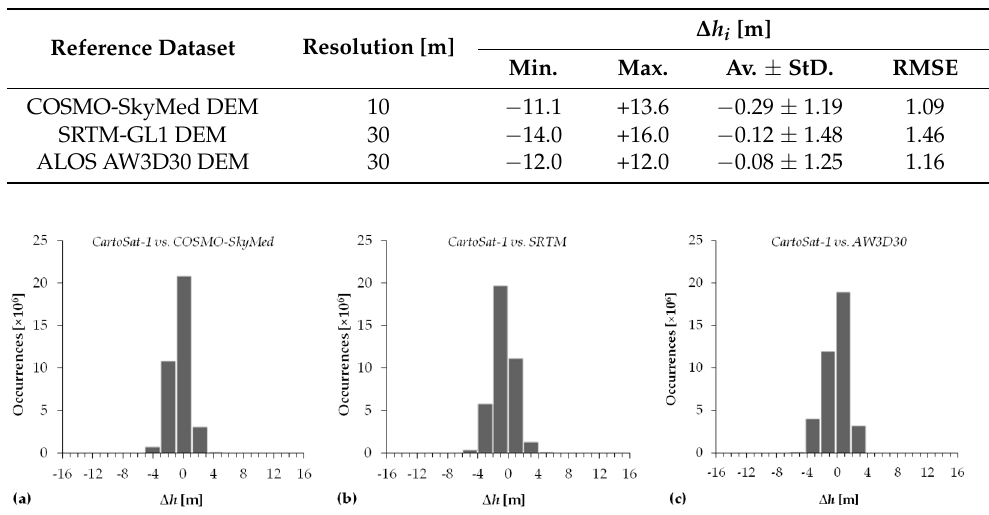
Figure 4. Distribution of the observed elevation differences ( ∆ h i ) between the CartoSat-1 DSM and the three reference DEMs: ( a ) COSMO-SkyMed, ( b ) SRTM 30 m and ( c ) AW3D30.